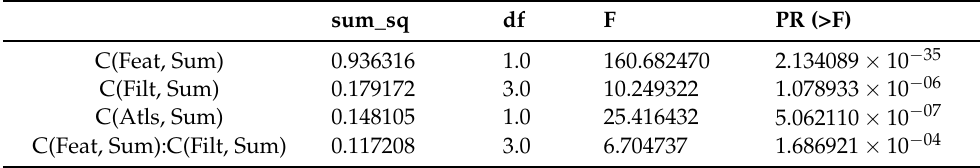
Table 3. Multifactorial (3-way) ANOVA test results after removing insignificant